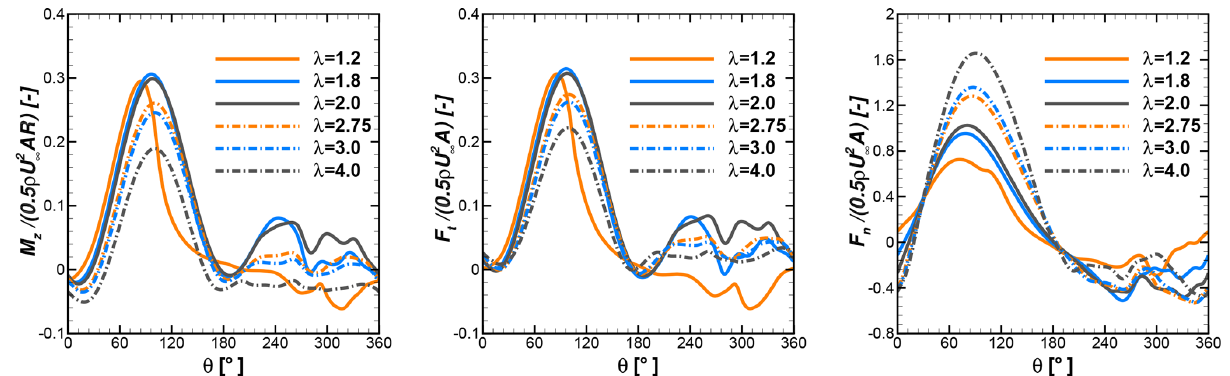
Figure 7. Normalized moment and tangential and normal forces of a single blade at different tip speed ratios under reference conditions with uniform inflow of 8ms − 1 without terrain.